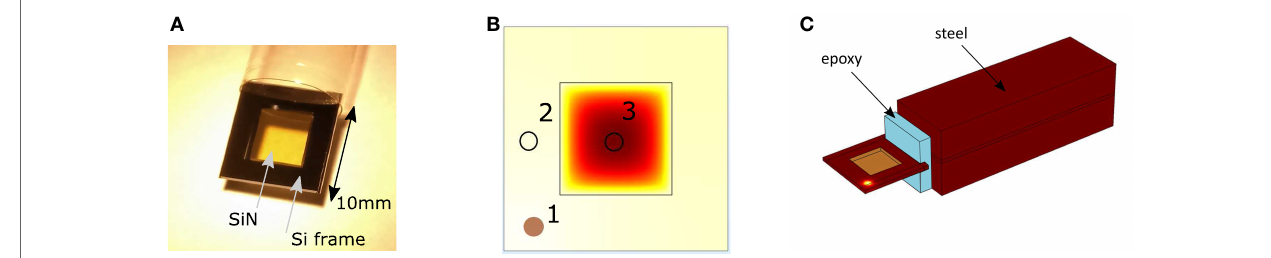
FIGURE 1 | (A) Photo of a Si 3 N 4 membrane fabricated by Norcada 6 : a cSi substrate was coated with Si 3 N 4 using low-pressure chemical vapor deposition (LPCVD) and a 5mm (cid:2) 5mm window was etched into the cSi substrate. (B) Schematic of the membrane: At position 1, 532nm laser light was used to heat the cSi frame. At position 2, 1,550nm laser light was used to heat the membrane. The temperatures listed in Table 1 were obtained at the positions marked with 2 and 3. (C) Geometry of the finite element model of the membrane (in this case heated at position 1) and its mounting. In the experiment, the membrane is glued to a screw with an epoxy without direct contact between the screw and the membrane. In the model, this is represented by the blue shape with thermal properties of an epoxy, while the rest of the mount is made of structural steel.